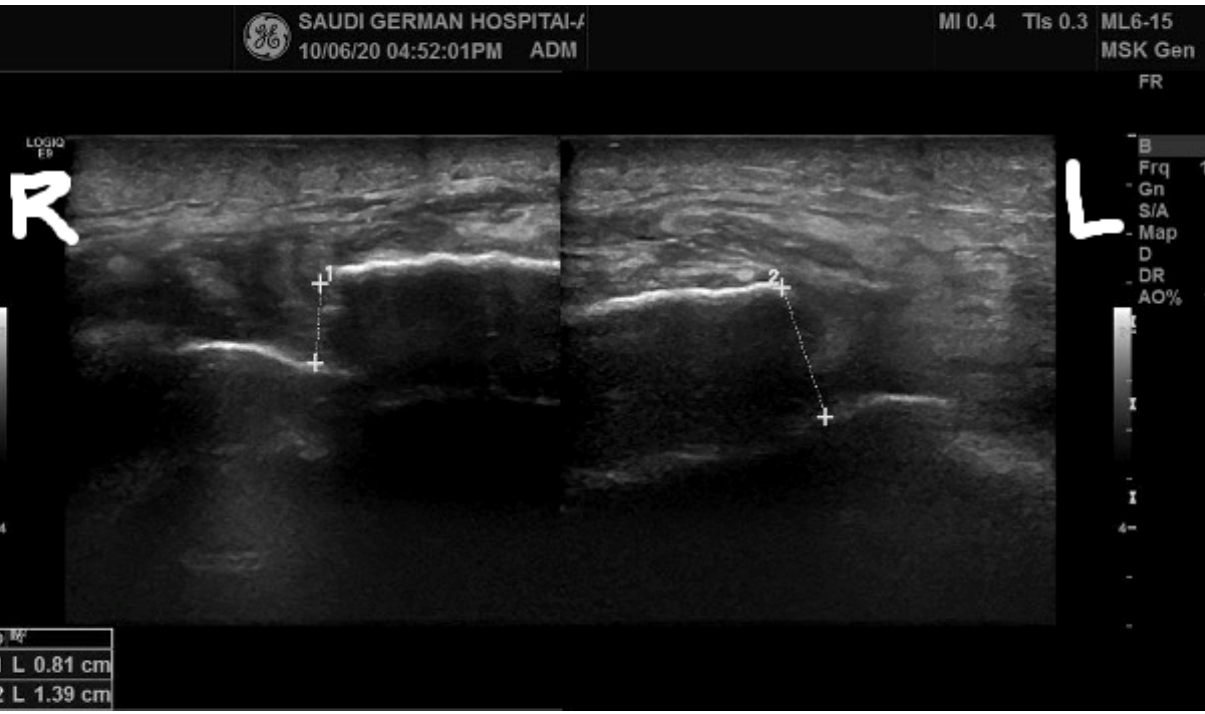
Figure 5. Ultrasound report of the quadriceps tendon with complete bilateral rupture. R: Indicates right side; L: Indicates left side.